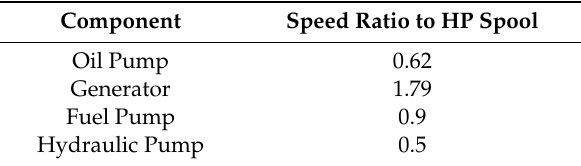
Figure 1. Schematic of accessory gearbox (AGB) gear set configuration. Table 1. Accessory gearbox drives speeds.